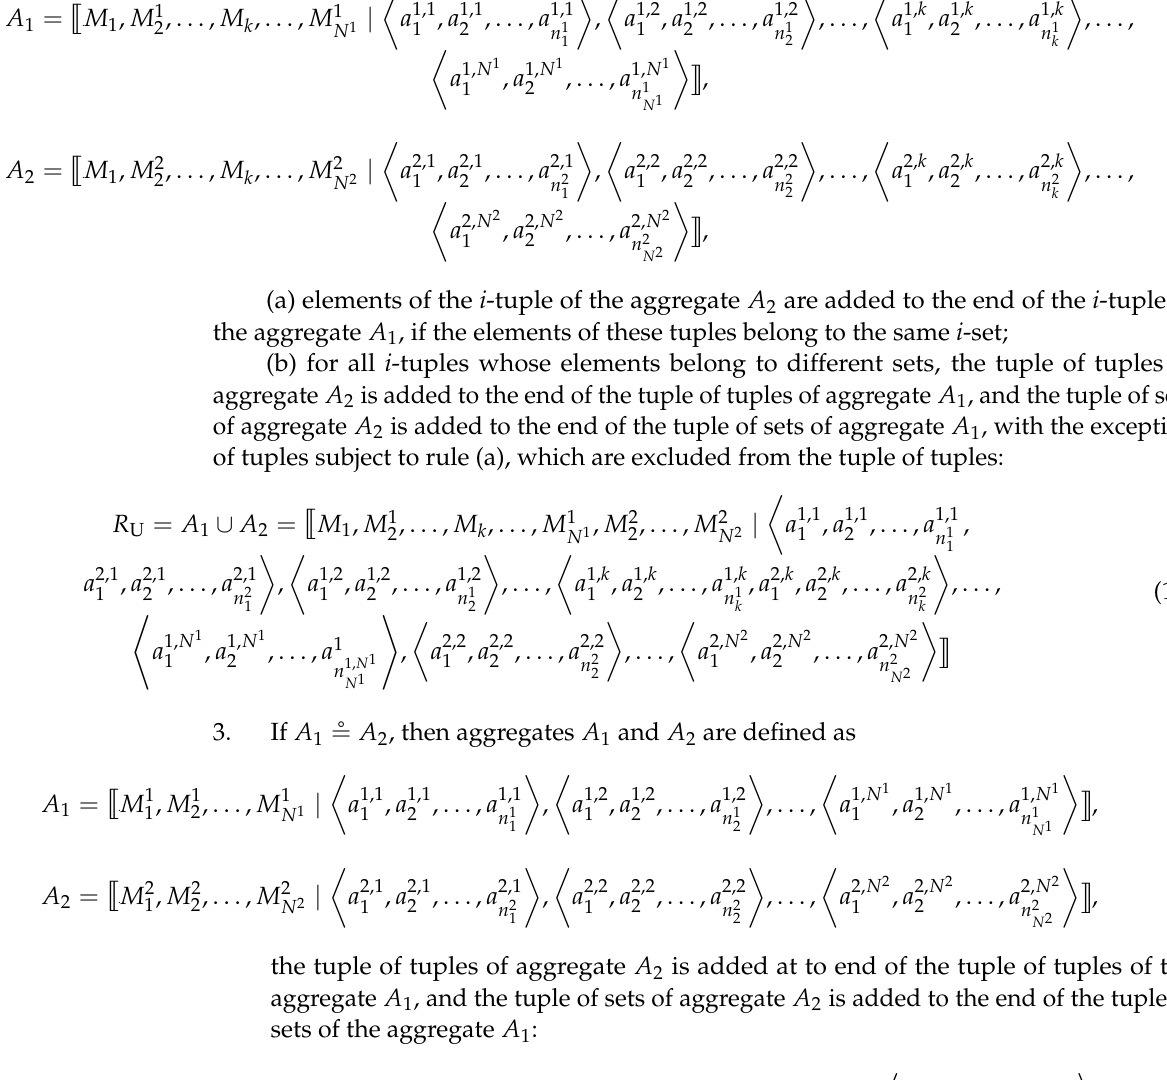
Figure 4. An example of two hiddenly compatible aggregates.